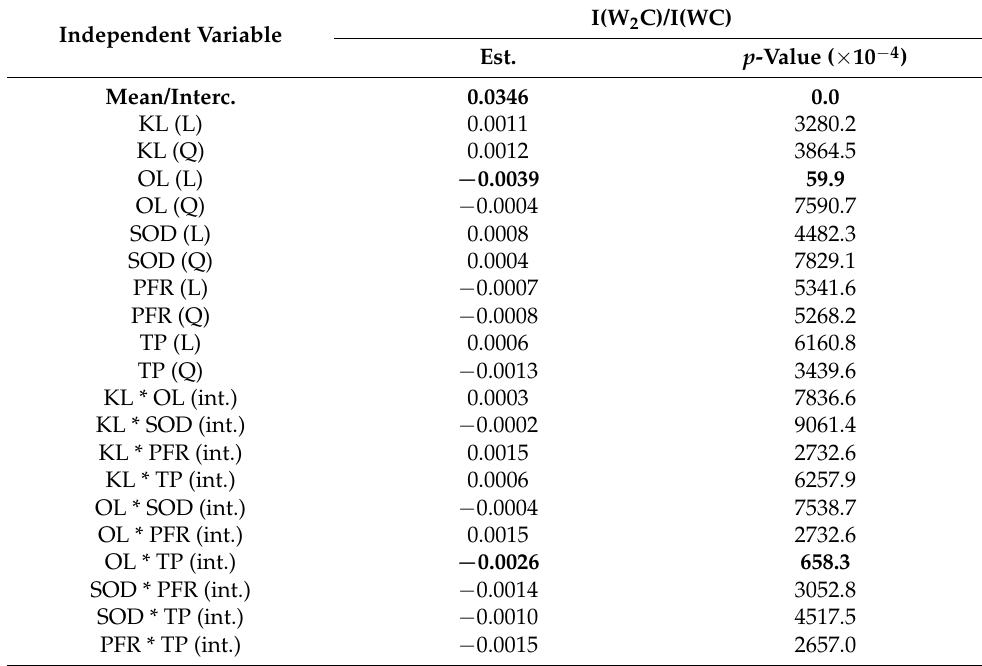
Table 3. Effect estimates and p -values ( α = 0.1) for the CCD.